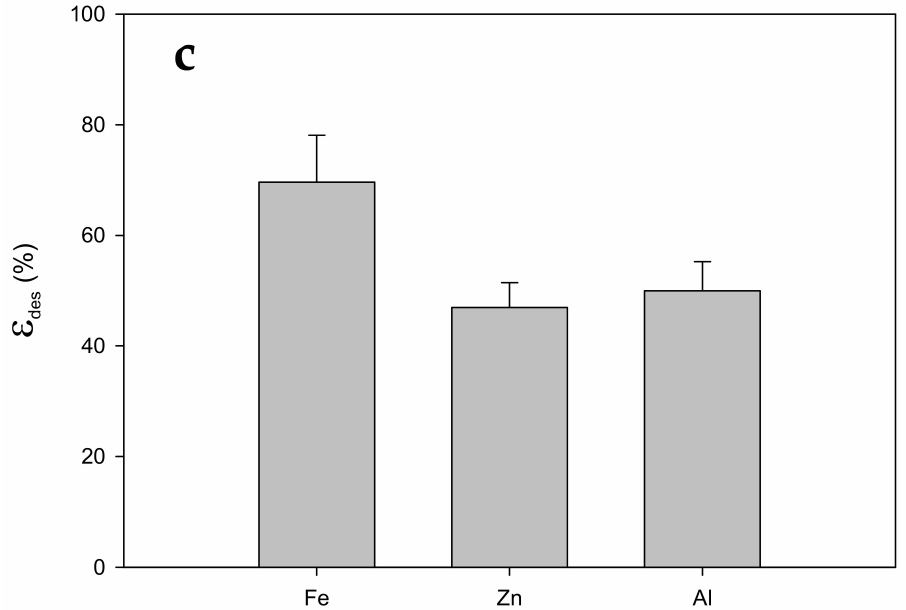
Figure A7. The ε des of Fe, Zn and Al with 10 mL of HCl ( a ), HNO 3 ( b ) and EDTA 15% + NaOH 0.5 N ( c ) solutions after 120 min at agitation of 50 rpm. Different letters means differences according to Tukey-Kramer multiple comparison test ( p < 0.05).